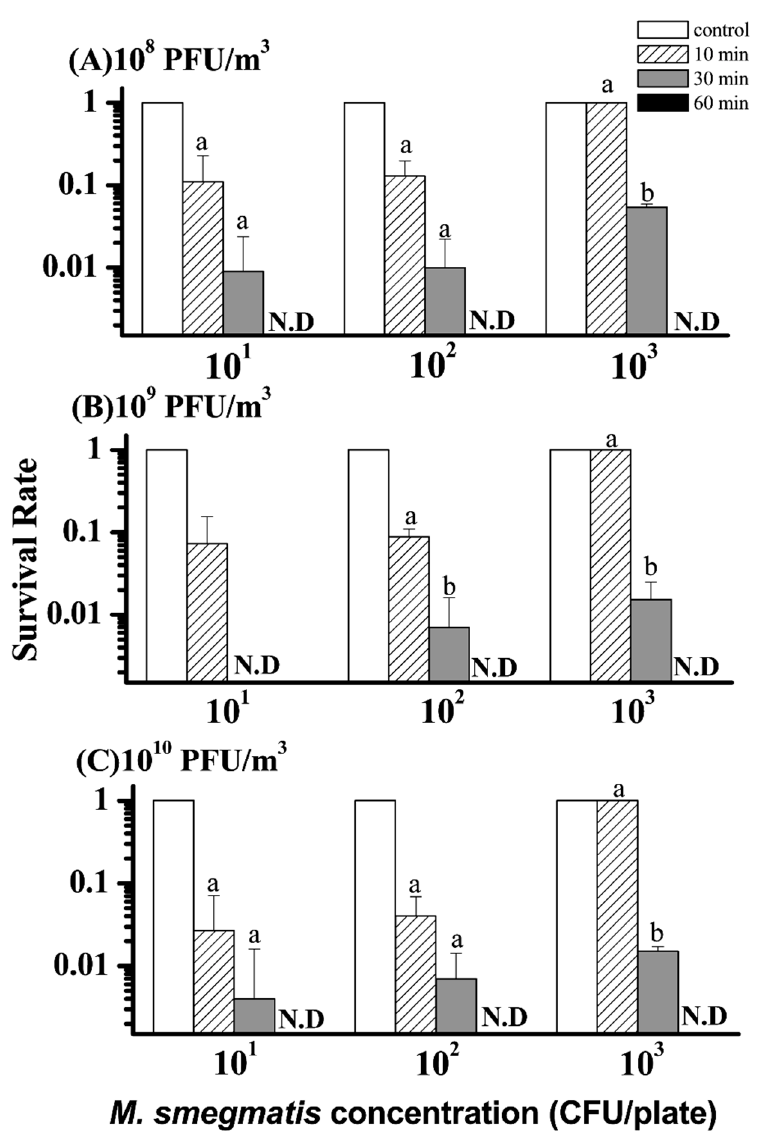
Figure 6. Bactericidal e ff ect of di ff erent concentrations, ( A ) 10 8 , ( B ) 10 9 , and ( C ) 10 10 PFU / m 3 , of φ BTCU-1 aerosols on an agar plate contaminated with di ff erent concentrations of M. smegmatis at three exposure times of 10, 30, and 60 min (phase two study). The survival rate was calculated as the log 10 of N t / N 0 , where N 0 is the number of bacterial colonies recovered from challenging with water fog and N t is the number of colonies recovered from challenging with φ BTCU-1 aerosols. The histogram bars with the same letter represent they have similar survival rates that are not significantly di ff erent ( p > 0.05, Dunn’s multiple comparison test). Experiments were performed in triplicate and the data shown represent the mean ± standard error of the mean. N.D. means not detected.